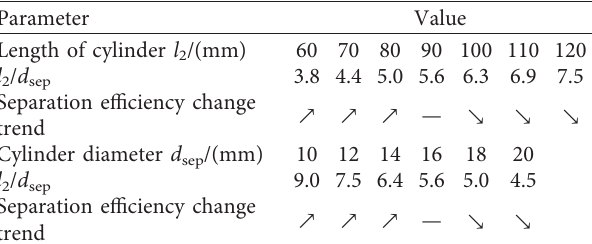
Table 3: Influence trend of structure parameters on separation